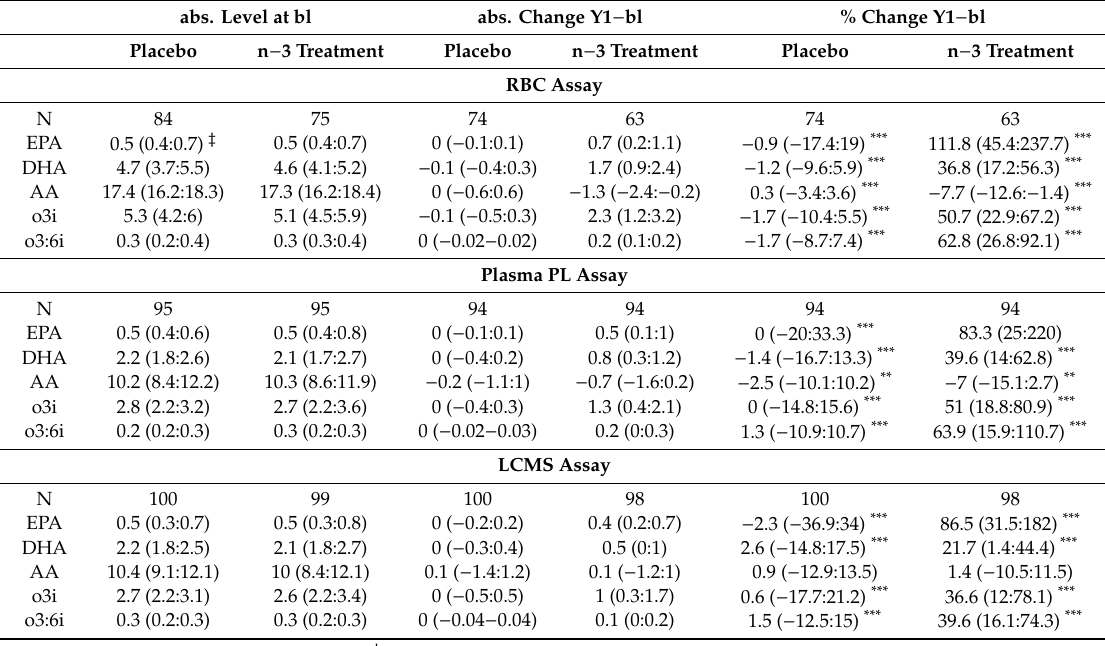
Table A1. Significant one-year changes in fatty acid distribution according to the randomized treatment groups: n-3 vs.